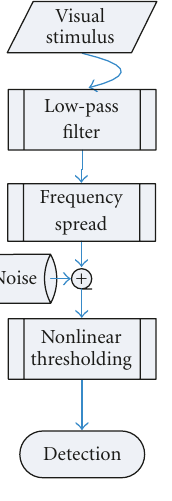
Figure 2: A three-stage model of CSF, based on implicit masking.